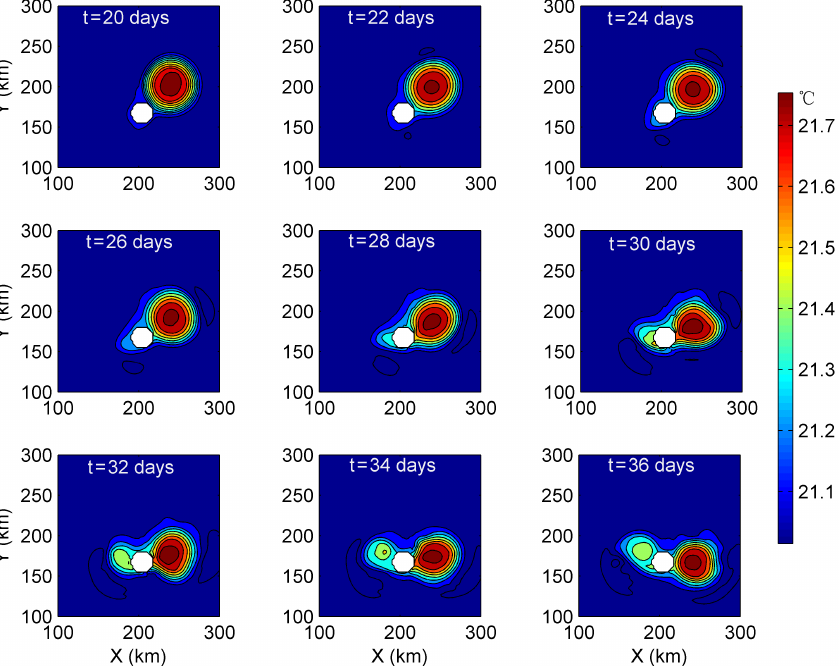
Figure 7. The temporal evolution of the eddy in the interaction with an island of 20km in diameter. The colours represent the temperature at 100m depth and the solid lines are temperature contours.